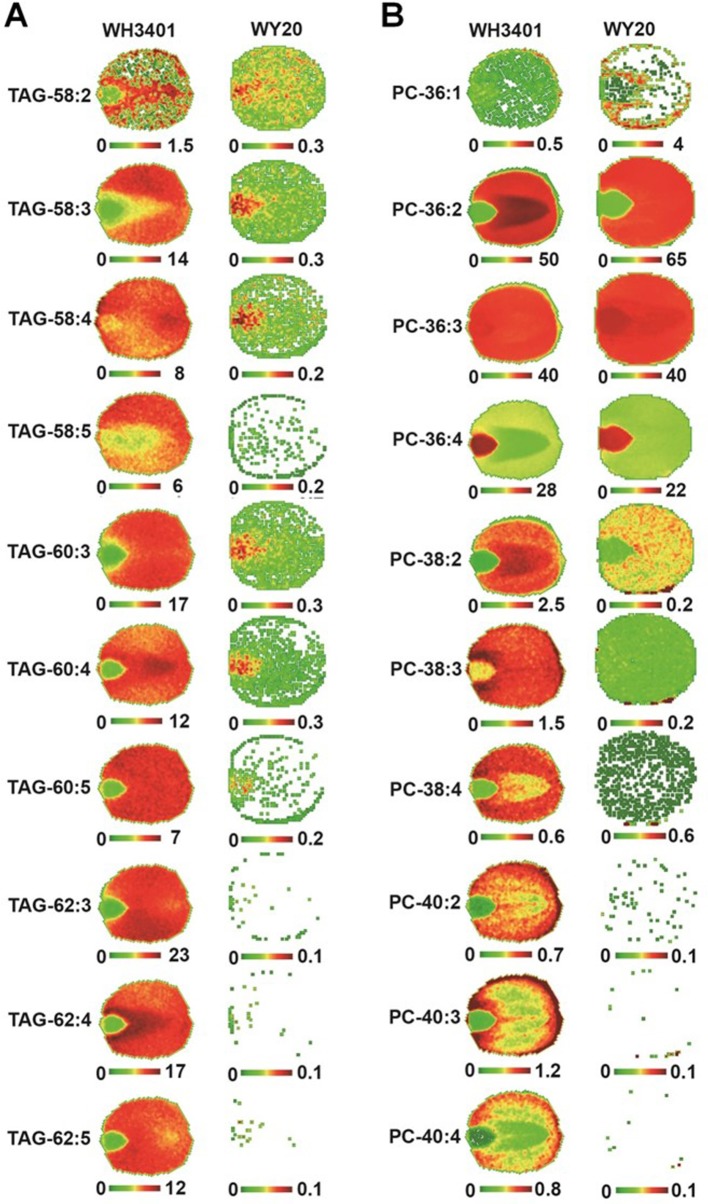
Spatial distribution of triacylglycerol (TAG) and phosphatidylcholine (PC) species in mature seeds. False-colored images of embryo cross sections showing the spatial distribution of selected TAG (A) and PC (B) species in WH3401 and WY20 seeds. Three biological replicates with consistent results have been analyzed (
Figure S3
).